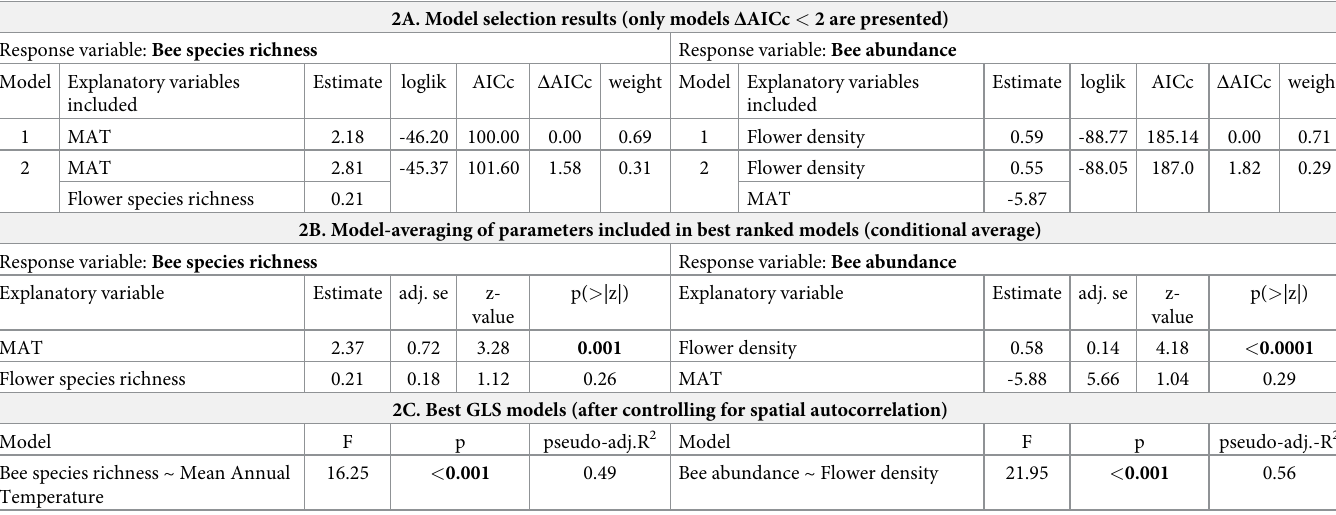
Best fitting models relating Bee species richness and Bee abundance (as response variables) vs climatic (MAT, MAP) and flower variables (Flower species richness, Flower density). In Table 2A. best ranked models ( Δ AICc < 2) are represented for each of bee response variables (Bee species richness (left) and Bee abundance (right)). In Table 2B. model-averaged parameters for explanatory variables are presented for each bee response variable. In Table 2C. parameters for best (GLS) models (after controlling for spatial correlation) are presented. Abbreviations: MAT: Mean Annual Temperature (˚C); MAP: Mean Annual Precipitation (mm); adj.: adjusted; se: standard error. Significant values are marked in